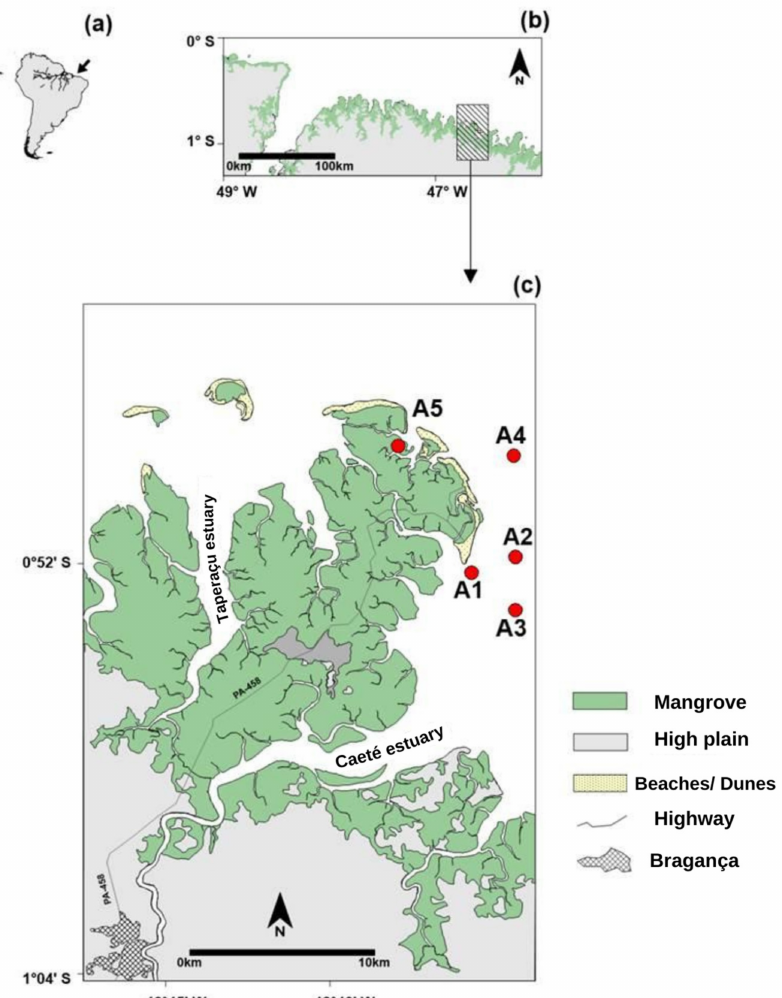
Figure 2. Geographic location area of study in the Brazil ( a ). Geographic area of study in the Amazon Continental Shelf ( b ). Geographic location of the Amazon estuary (Ajuruteua peninsula, Bragança, PA) ( c ) with the sampling areas (A1, A2, A3, A4, and A5) of Genyatremus luteus , carried out during the period from April/16 to